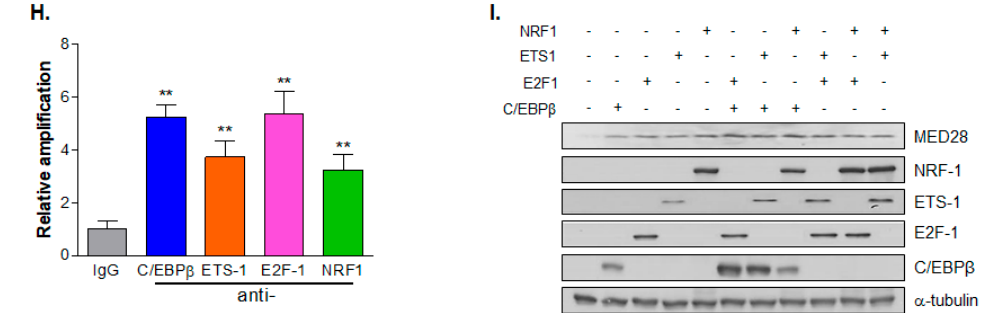
Figure 1. Analysis of the mammalian mediator complex subunit 28 ( MED28) promoter. ( A ) pGL3-basic vectors containing the indicated version of the MED28 promoter were transfected into cells, and luciferase activity was measured as described in the Materials and Methods section. The luciferase activity was normalized to Renilla luciferase activity. Data represent the mean ± SEM of three independent experiments ( n = 3). ( B ) The putative transcription factor-binding sites were analyzed and are indicated in the − 0.1 kb region of the MED28 promoter. PGL3-basic vectors containing